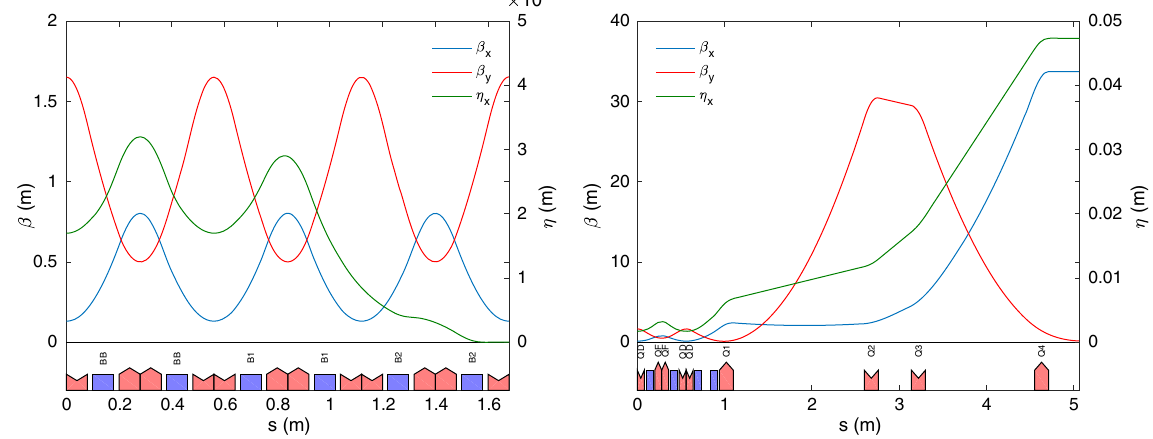
FIG. 7. Illustration of dispersion suppressor (left plot) and dispersion amplifier (right